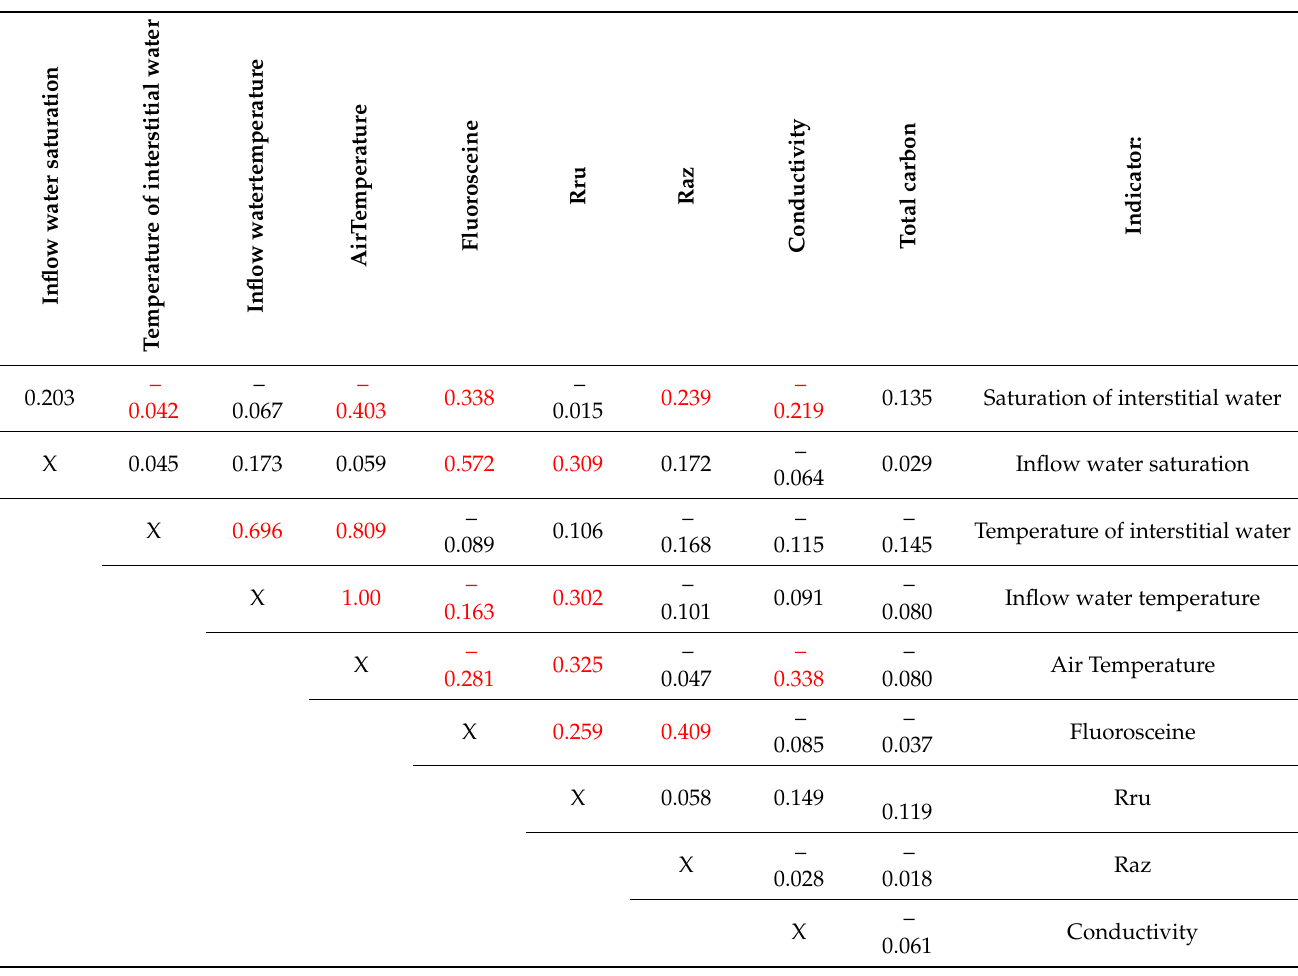
physicochemical properties of interstitial waters).